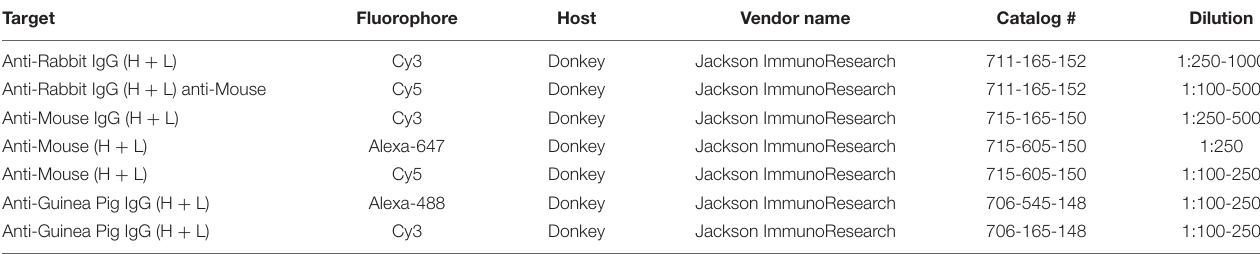
TABLE 2 | List of secondary antibodies